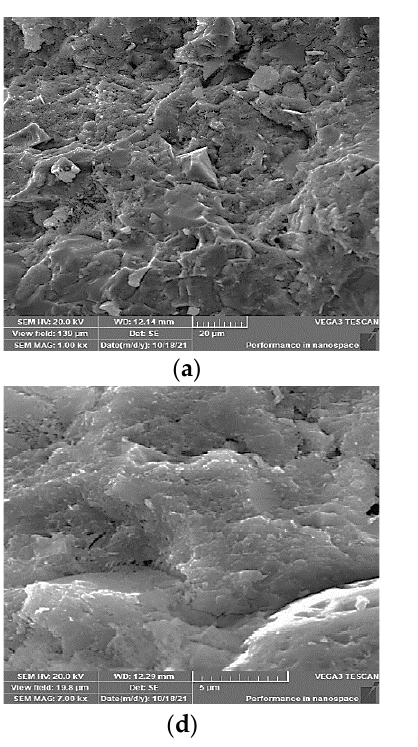
Figure 12. SEM with various magnification factors ( a – d ); ( e ) EDX for the control mix at 22 °C cur- ing temperature.